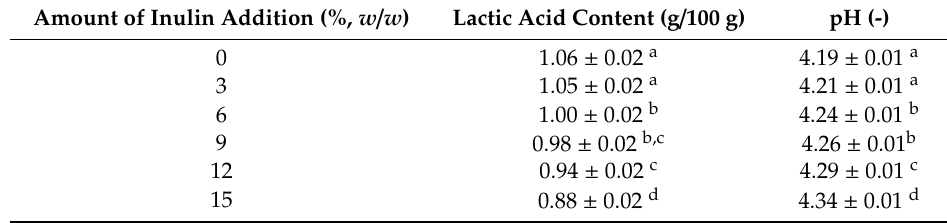
Table 1. Average lactic acid content and pH values of yogurts with 0%, 3%, 6%, 9%, 12% or 15% w / w inulin